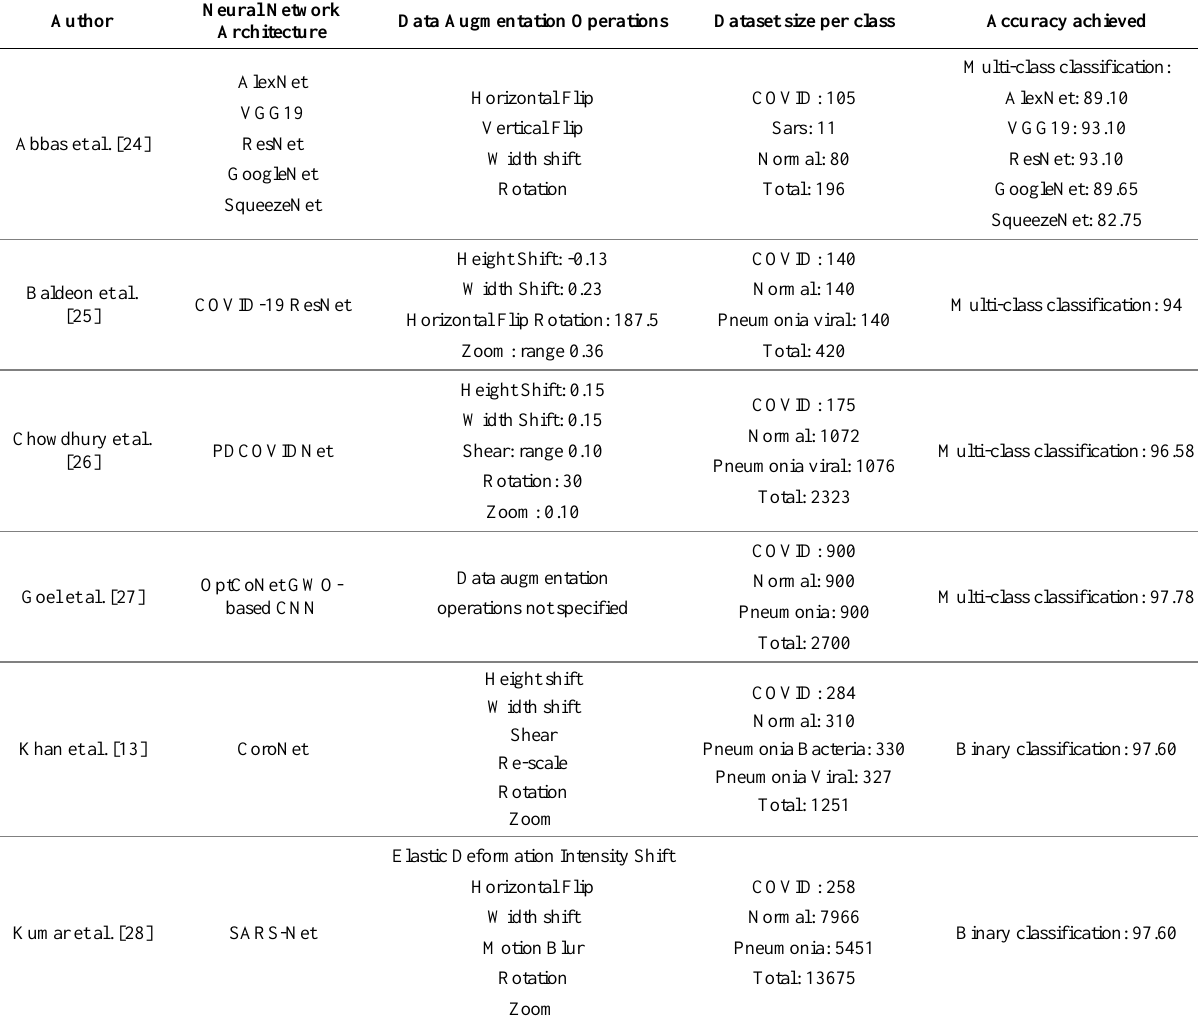
Table 1. Data Augmentation Techniques for COVID-19 detection in Chest X-ray